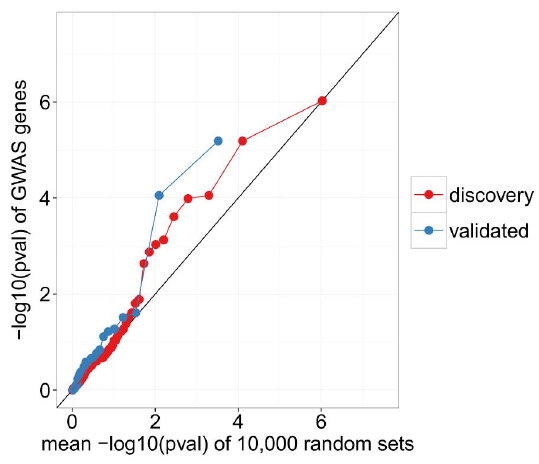
Figure 4. GWAS identified genes appear to be enriched for differential expression. We see smaller differential expression p- values for GWAS genes than for randomly selected genes.